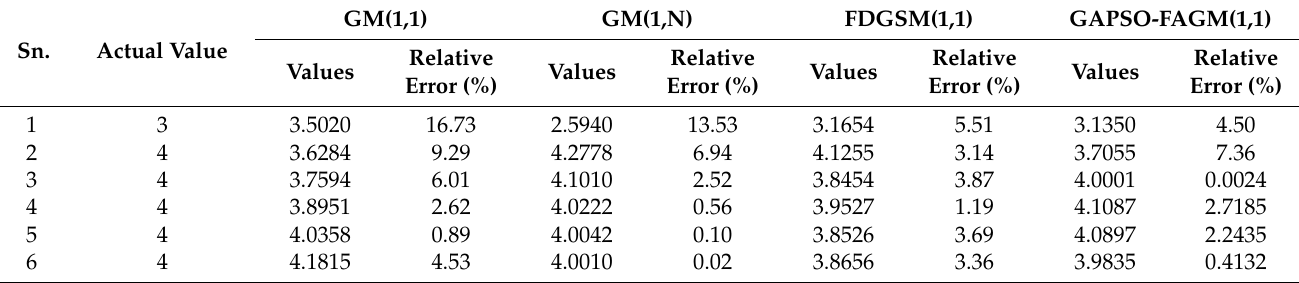
Table 4. The predicted values of the test set with the four models and their relative errors.